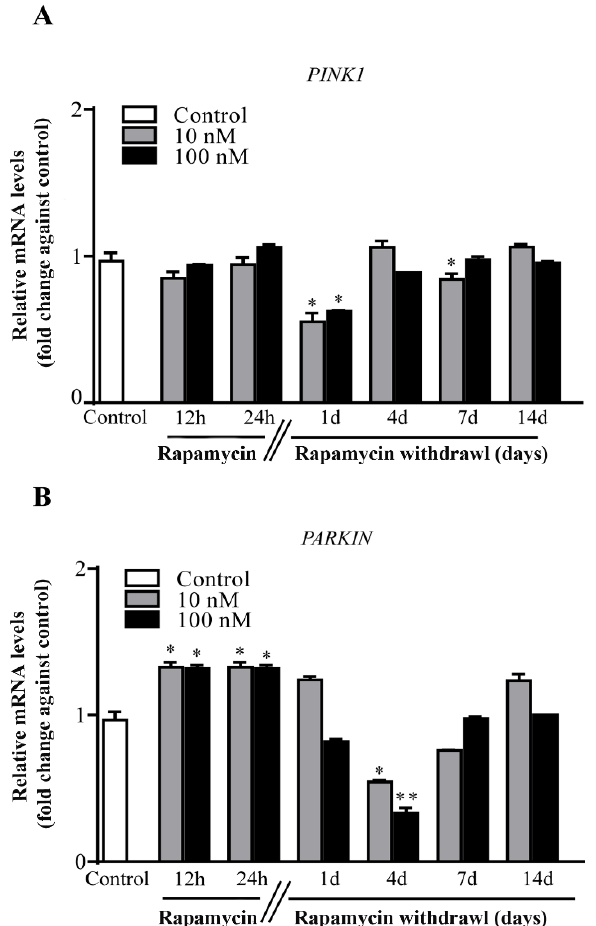
Figure 5. Rapamycin transiently modifies expression of PINK1 and PARKIN . RT-PCR for ( A ) PINK1 and ( B ) PARKIN . PINK1 never increases following rapamycin. This gene undergoes a decrease following 1 d of rapamycin (10 nM and 100 nM withdrawal), with a slight decrease also measured at 7 d following the lowest dose. In contrast, PARKIN rose early on during rapamycin (both doses) administration and similarly to PINK1 decreased transiently at 4 d following both doses of rapamycin. Counts represent the mean ± SD. * p ≤ 0.05 compared with control. ** p ≤ 0.05 compared with control and 10 nM